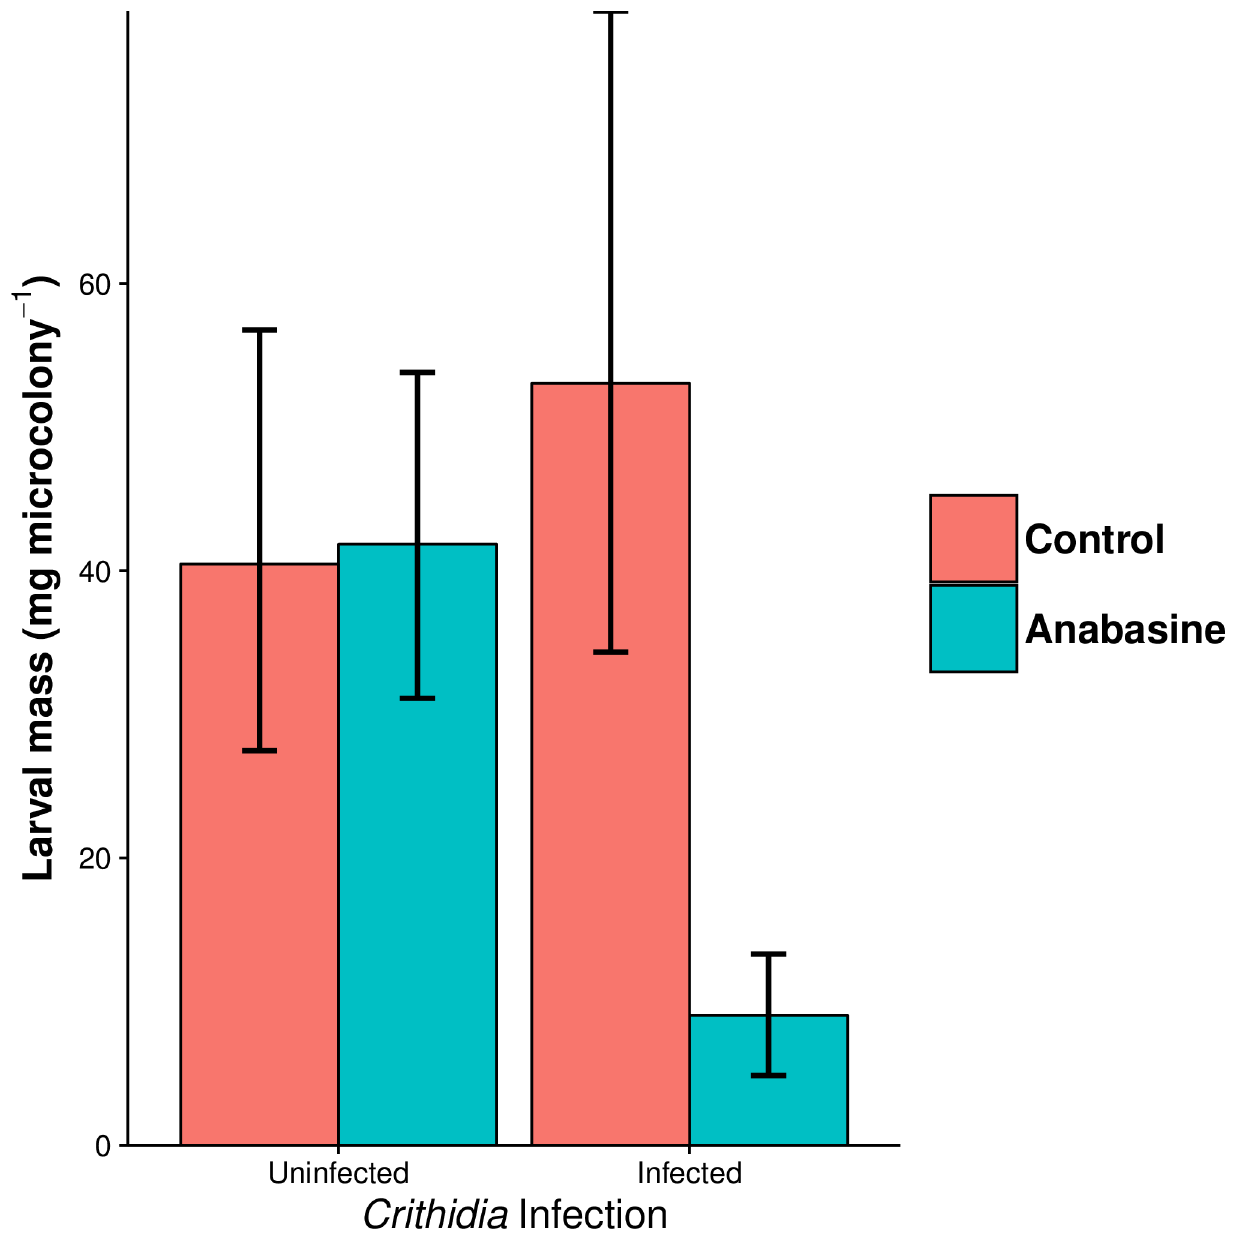
Fig 4. Effects of Crithidia infection on microcolony production of larvae in the Life History Experiment. Microcolonies that produced eggs were dissected 14 d after first egg productionfor measurement of larval masses. Bars and error bars show least squares means and standard errors. Error bars are asymmetric due to back-transformation via the gamma family model’s log link function.